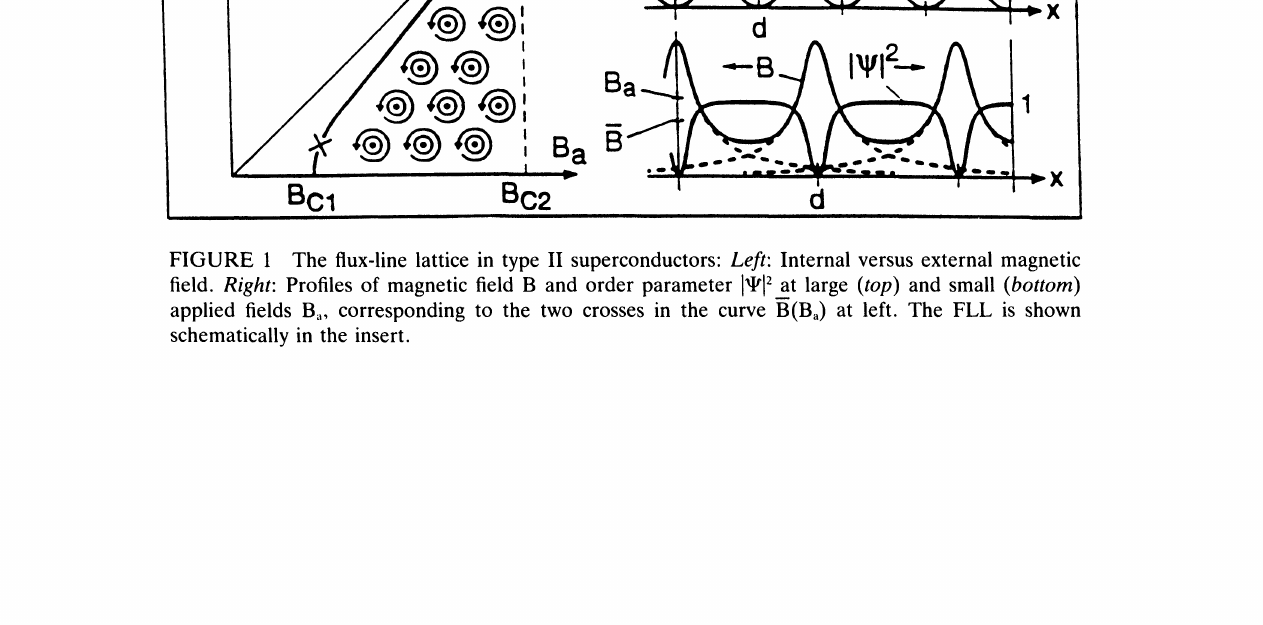
The flux-line lattice in type II superconductors: Left: Internal versus external magnetic field. Right: Profiles of magnetic field B and order parameter I,I,I at large (top) and small (bottom) applied fields B,, corresponding to the two crosses in the curve B(B,) at left. The FLL is shown schematically in the